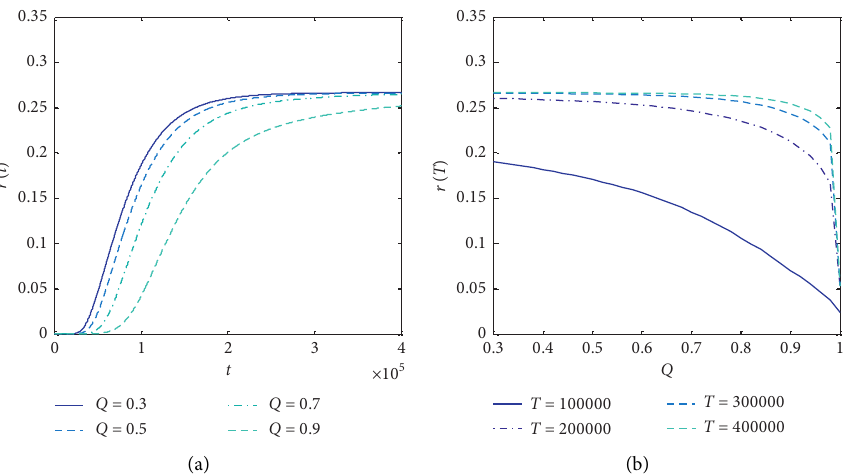
Figure 4: (a) Proportion of RI nodes against time t with b � 0.7 and Q � 0.3, 0.5, 0.7, 0.9. (b) The final percentage of RI nodes with different lifetimes when Q varies from 0.3 to 1 and b � 0.7.